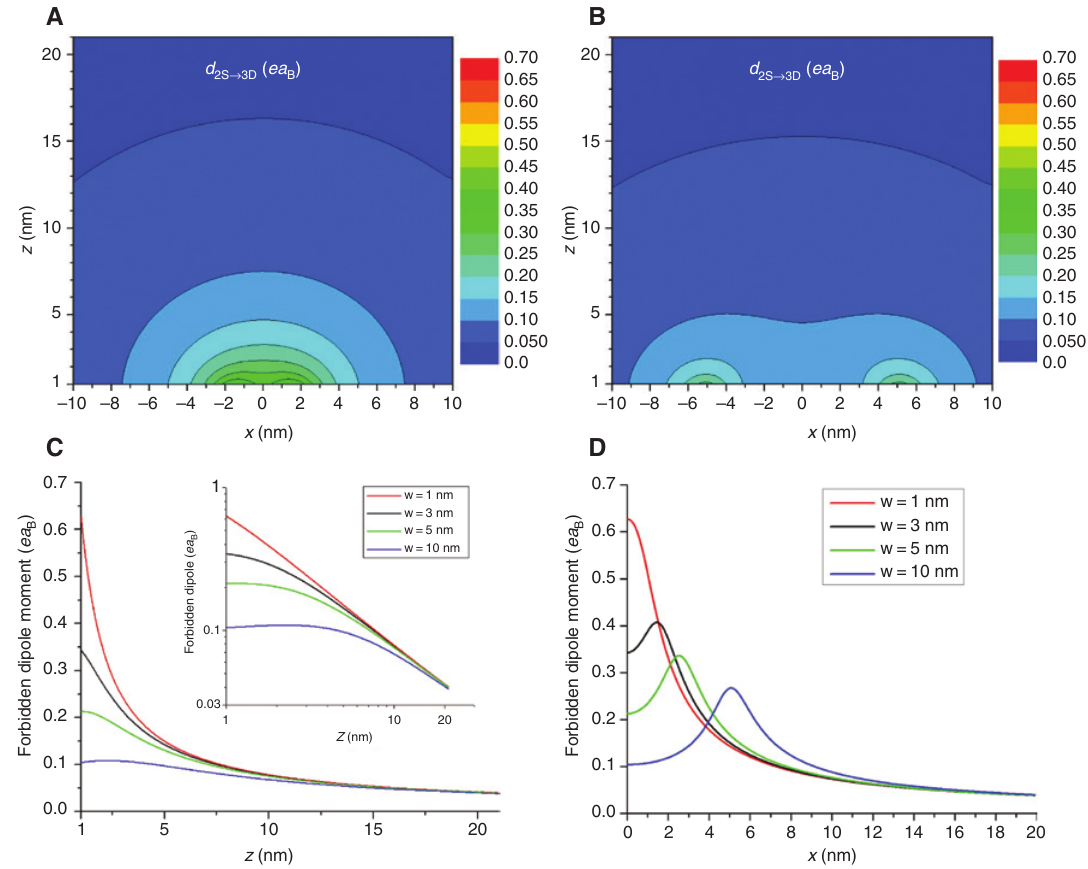
plotted (A) when w = 3 nm and (B) when w = 10 nm. (C) Total forbidden dipole moment along Figure 3: Total forbidden dipole moment d 2S → 3D the z -axis when w = 1, 3, 5, and 10 nm. (Inset: a log-log plot). (D) Total forbidden dipole moment when the observation is along the x -axis keeping z = 1 nm for w = 1, 3, 5, and 10